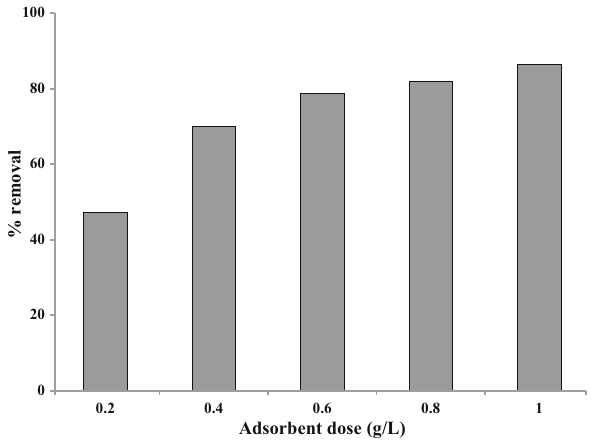
Fig. 5 Effect of C-ZMN dose on the removal of MB. Initial dye concentration: 100 mg L - 1 ; temperature: 298 K